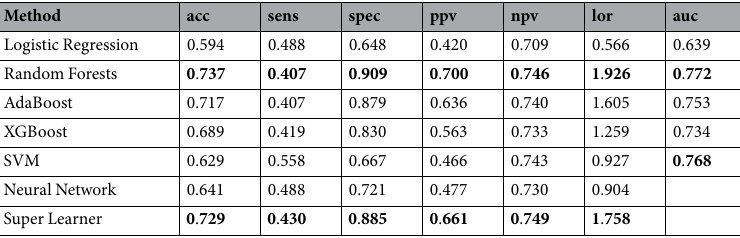
Table 20. Performance of model-based and model-free methods (using all features) on aggregated data.